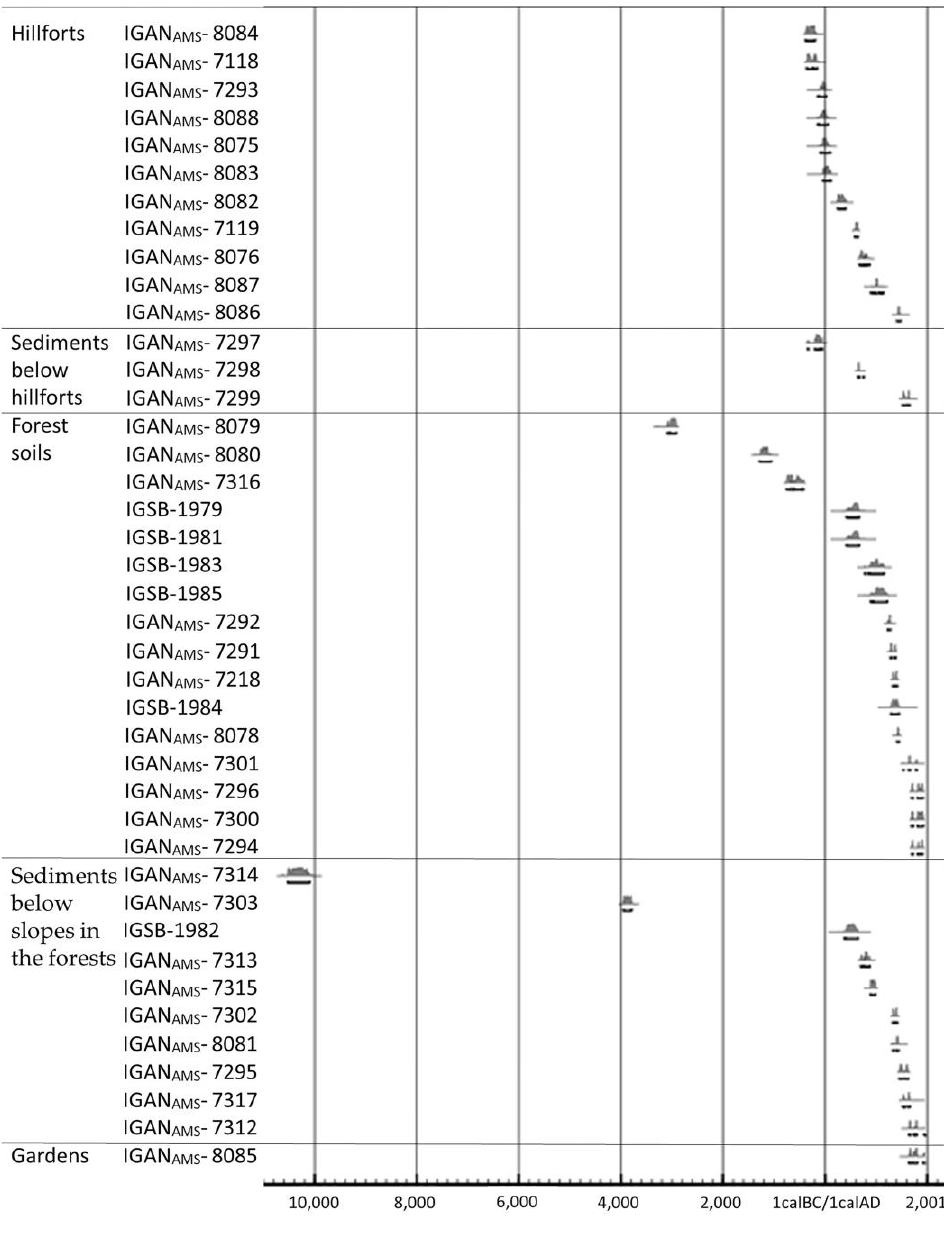
Figure 6. Probability curves of calibrated radiocarbon dates for charcoals from soil for studied types of land.